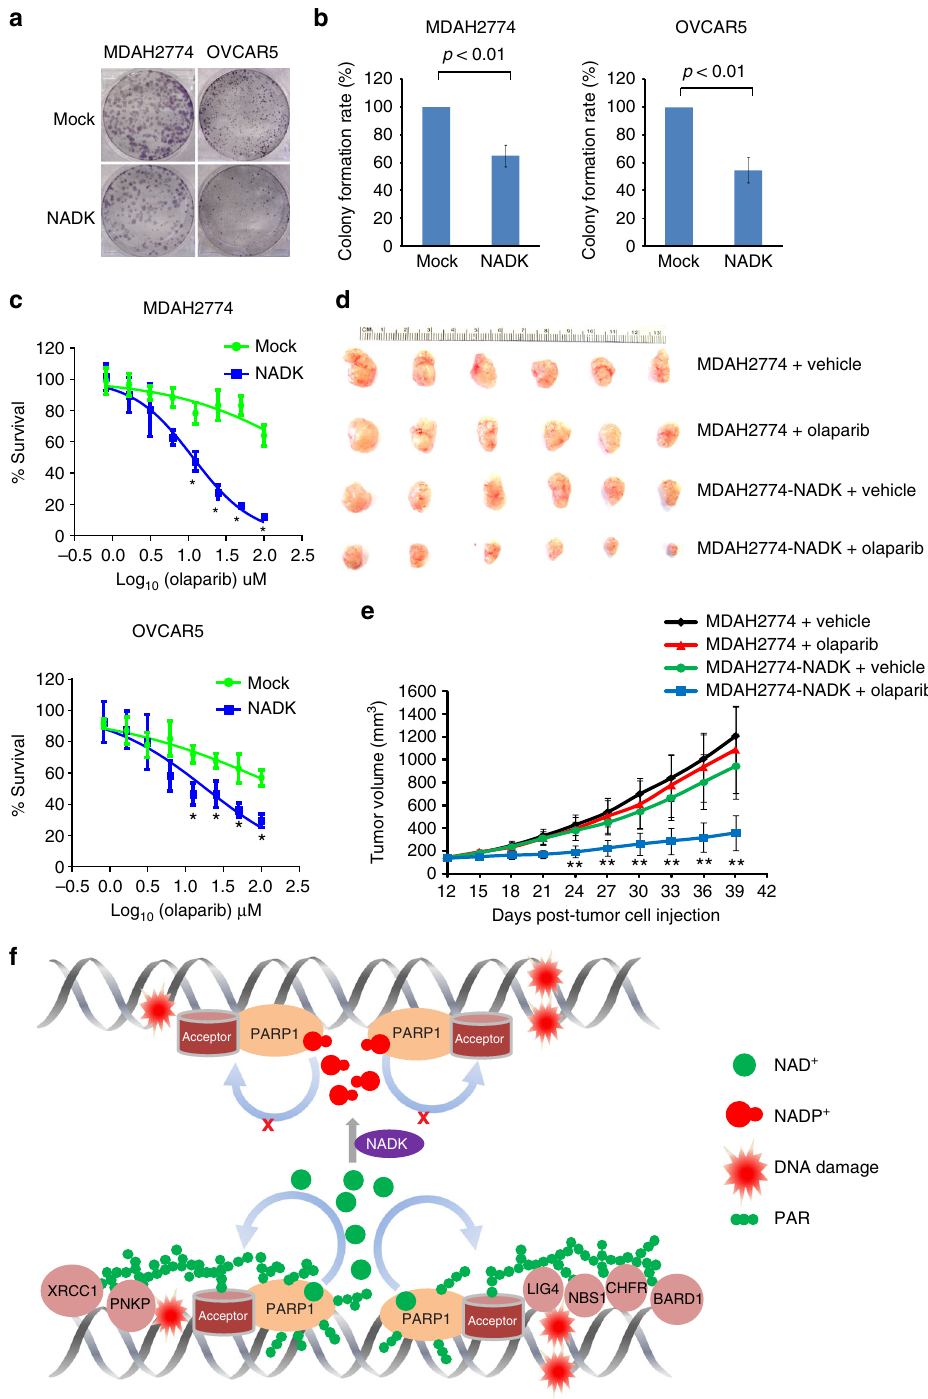
Fig. 6 High level of NADP + enhances the sensitivity of cancer cells to chemically synthesized PARP inhibitor. a , b Increased in the levels of NADP + and olaparib additively suppresses tumor cell growth. MDAH2774 and OVCAR5 with exogenous expression of NADK were examined for colony-formation assays. After treatment with 2 μ M olaparib for 2 weeks, the colonies were stained with crystal violet and counted. The results were summarized from three independent experiments. Data are presented as mean ± SD. p Value was calculated using two-tailed unpaired Student ’ s t tests. c High level of NADP + sensitizes tumor cells to olaparib. MDAH2774 and OVCAR5 with or without the exogenous expression of NADK were treated with olaparib at the indicated concentrations. MTT (3-[4,5-dimethylthiazol-2-yl]-2,5 diphenyl tetrazolium bromide) assays were performed to examine cell viability. The data are summarized from three independent experiments. Data are presented as mean ± SD. * p < 0.05. Data were analyzed using two-tailed unpaired Student ’ s t tests. d , e High level of NADP + sensitizes xenograft tumors to olaparib. Ovarian cancer xenografts were initiated by subcutaneous inoculation of MDAH2774 cells with or without exogenous expression of NADK in the lower fl ank of NOD SCID mice as described previously. In all, 5 mg kg − 1 olaparib was given intraperitoneally daily. Controls were dosed with vehicle only. Both digital photograph ( d ) and tumor growth curve ( e ) shows that exogenous expression of NADK signi fi cantly sensitized the MDAH2774 xenograft tumors to olaparib treatment. Data were presented as mean ± SD. ** p < 0.01. Data were analyzed using two-tailed unpaired Student ’ s t tests. f A model for NADP + -mediated suppression of PARylation and DNA damage